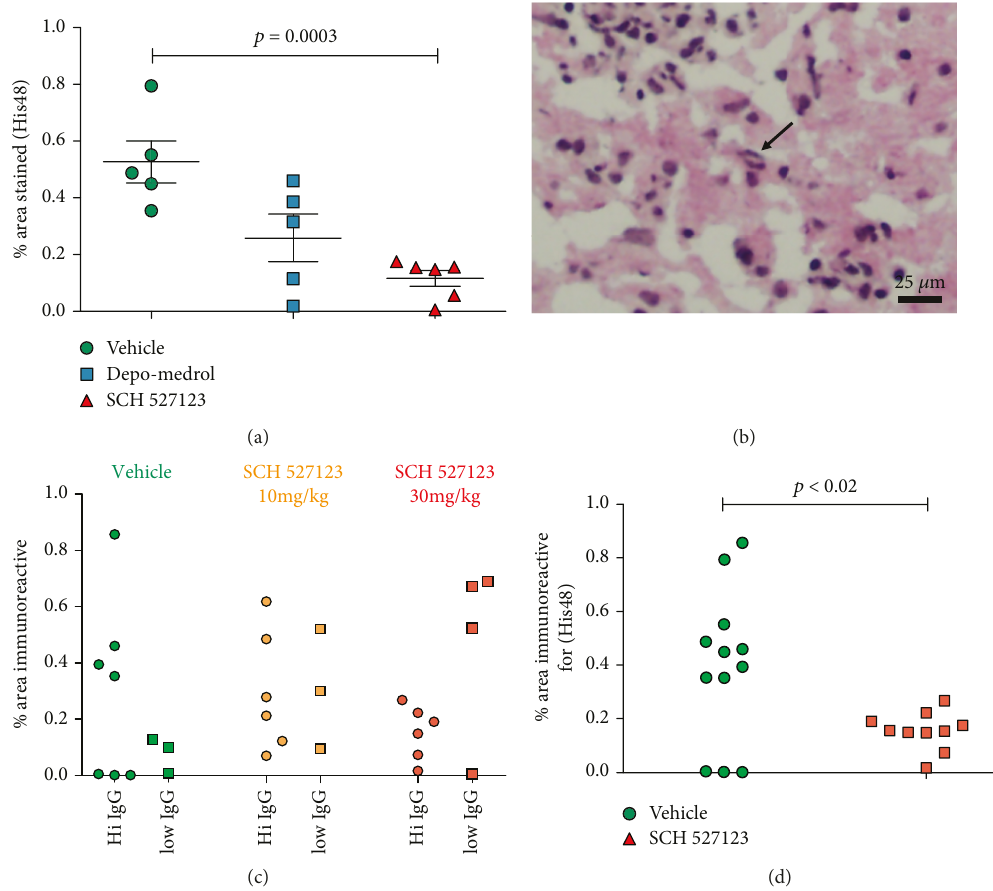
Figure 2: SCH527123 decreases neutrophil migration into the spinal cord of EAE rats with high human IgG levels. (a) In this cohort, Hu-IgG levels were high in both the vehicle- and SCH527123-treated animals. At 30 mg/kg, SCH527123 treatment (red triangles) signi fi cantly decreased neutrophil accumulation in the spinal cord of EAE rats when compared to the vehicle-treated group (green circles, p < 0 0003 ). (b) Examples of His48+neutrophils in the spinal cord of EAE rats (arrows, bar = 25 μ m ). (c) In this cohort, where Human IgG levels in the CNS were more variable, there is a trend towards decreased neutrophil recruitment in SCH527123 treatment at 30mg/kg compared to vehicle-treated animals only in animals with high Hu-IgG scores, but high variability in the vehicle-treated group limits the di ff erences between these groups (Student ’ s t -test p = 0 362 ; variance is signi fi cantly increased p < 0 02 ). (d) Pooling results for rats with high IgG in their spinal cords from the two cohorts for vehicle and SCH527123 treatment at 30mg/kg indicate that this higher dose signi fi cantly decreases His48+neutrophil recruitment following high levels of human IgG deposition in the spinal cord of EAE rats ( p < 0 02